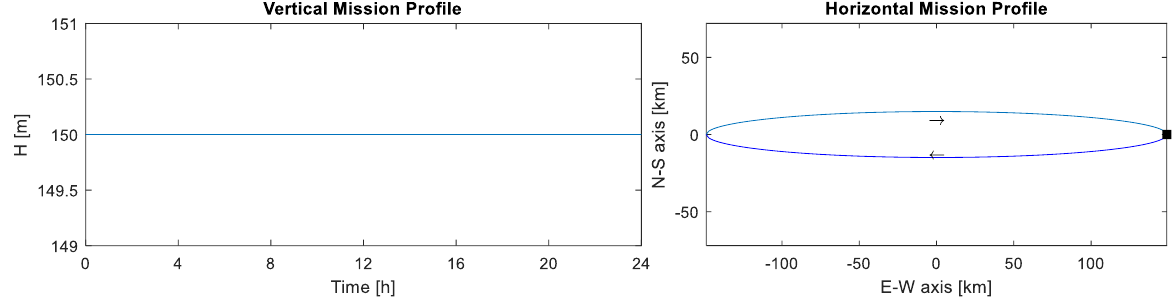
Figure 5. Examples of vertical ( left ) and horizontal ( right ) mission profiles.